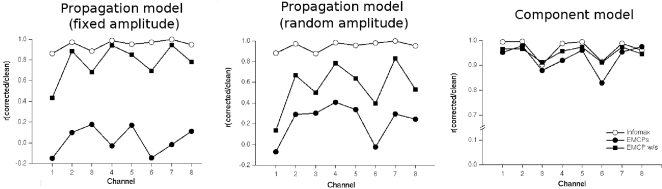
Correlation of clean uncontaminated data and corrected data.The figure shows the correlation between clean, uncontaminated data channels and corrected data channels for each simulation type.